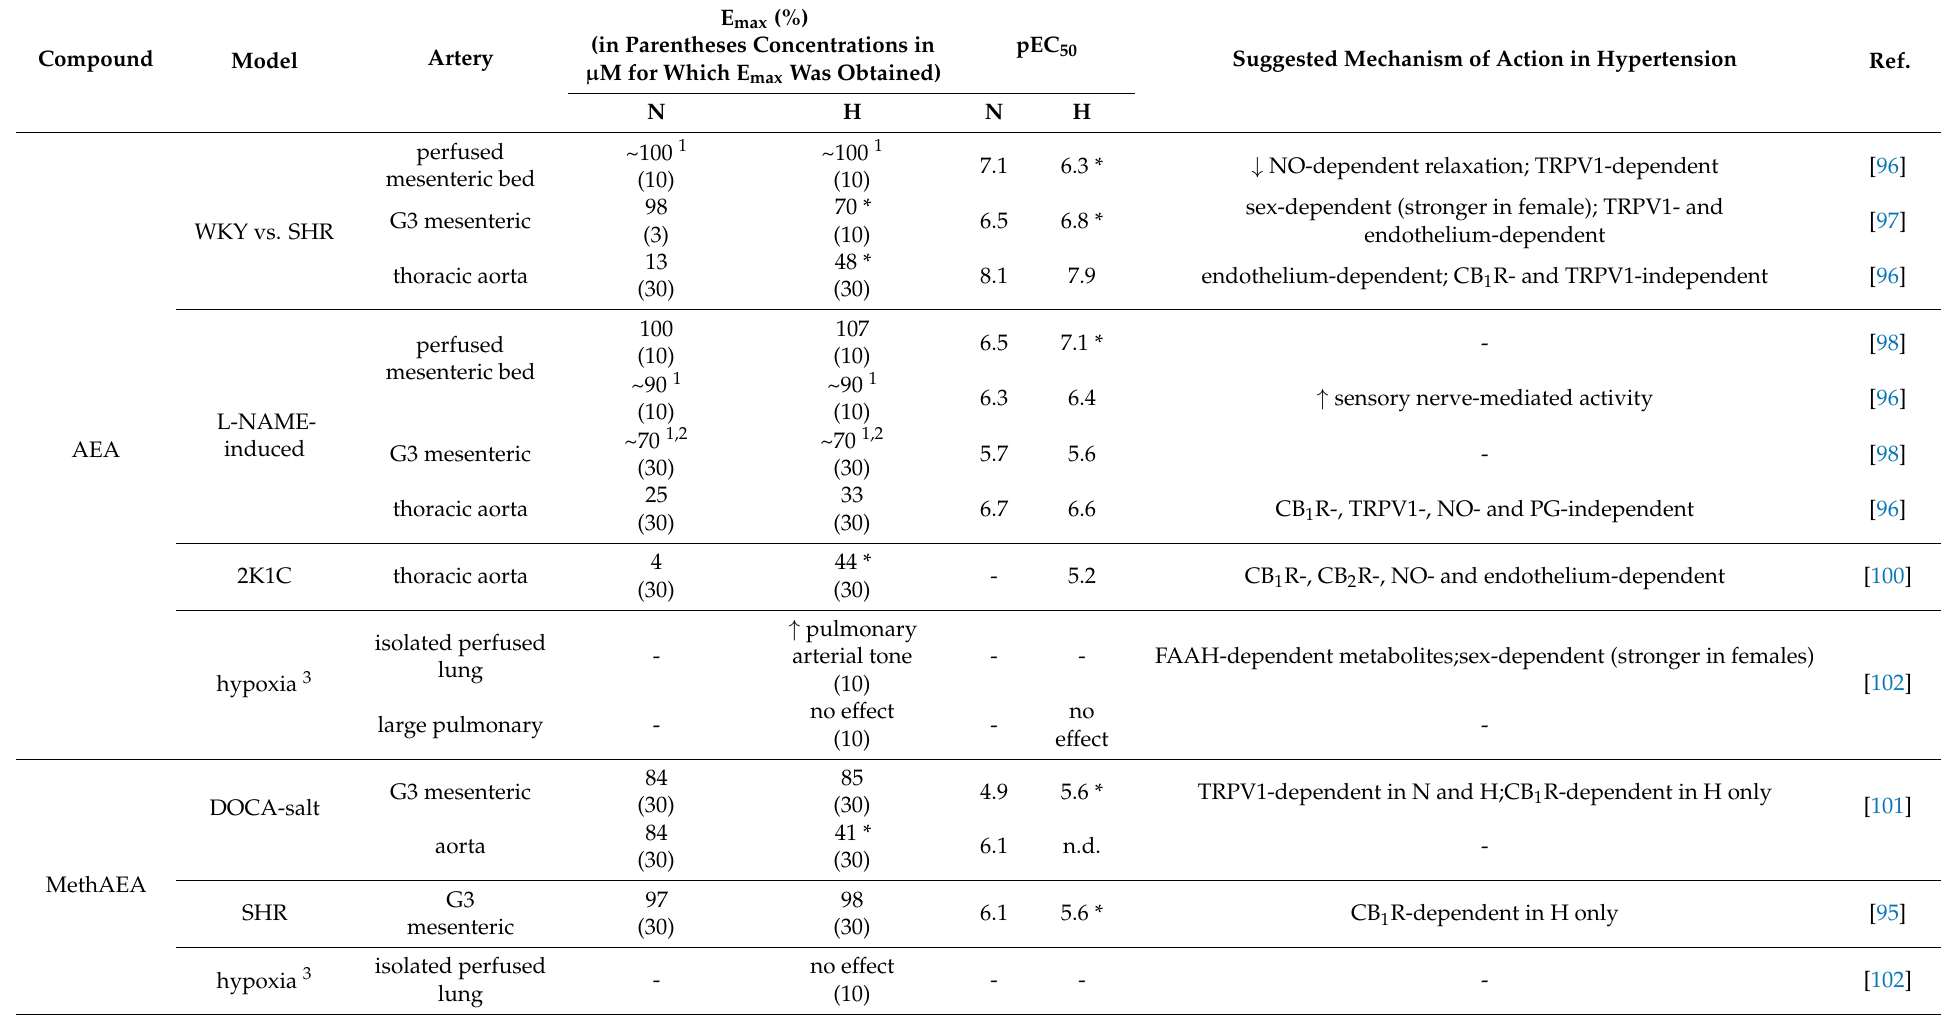
Table 2. Direct acute effects of (endo)cannabinoids on arteries isolated from rats (if not otherwise specified) with systemic or pulmonary hypertension.